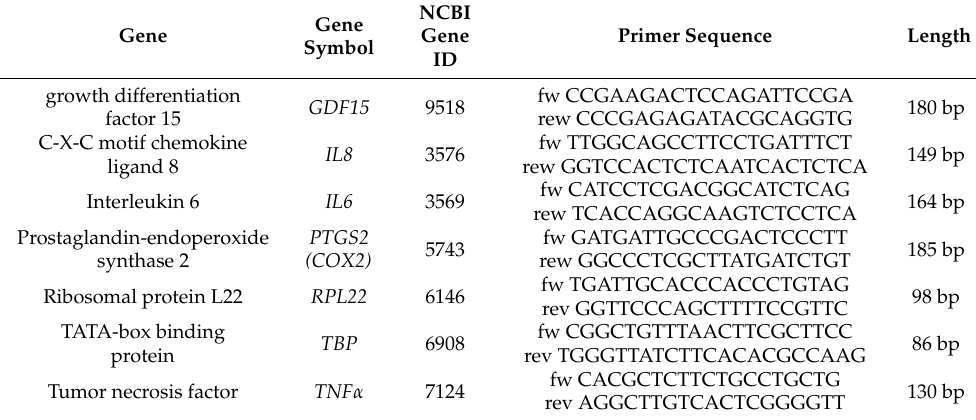
Table 1. qPCR primer sequences of human genes indicated in 5 (cid:48) -3 (cid:48) direction. bp, base pairs. Length, amplicon